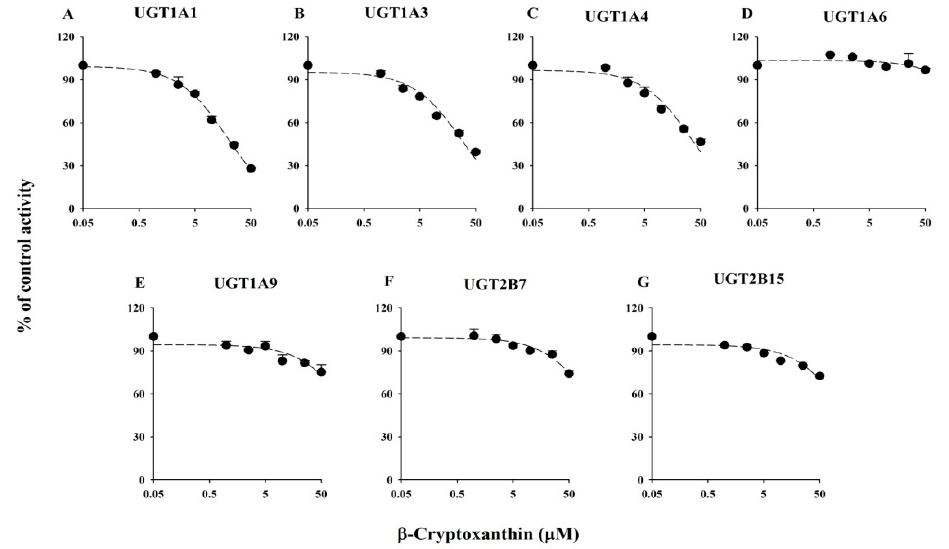
deviation of triplicate determinations.